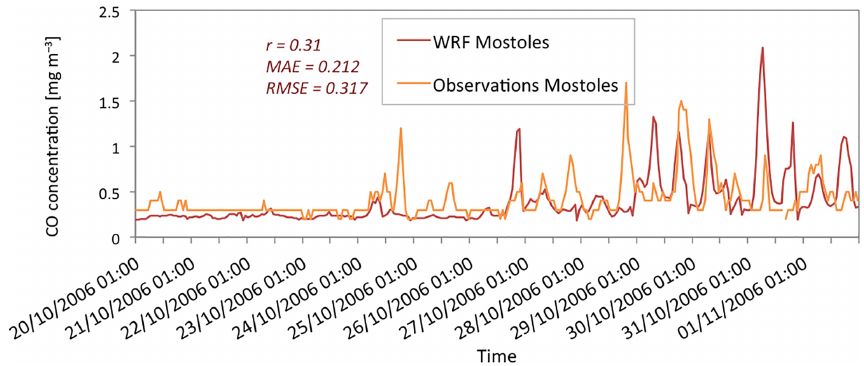
Figure 3. Hourly WRF surface concentrations (red line) compared to observations (orange line) at the Mostelos measurement station near Madrid for 10 days in